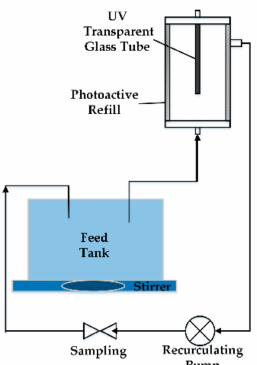
Figure 11. Schematic of solar catalyzed oxidation